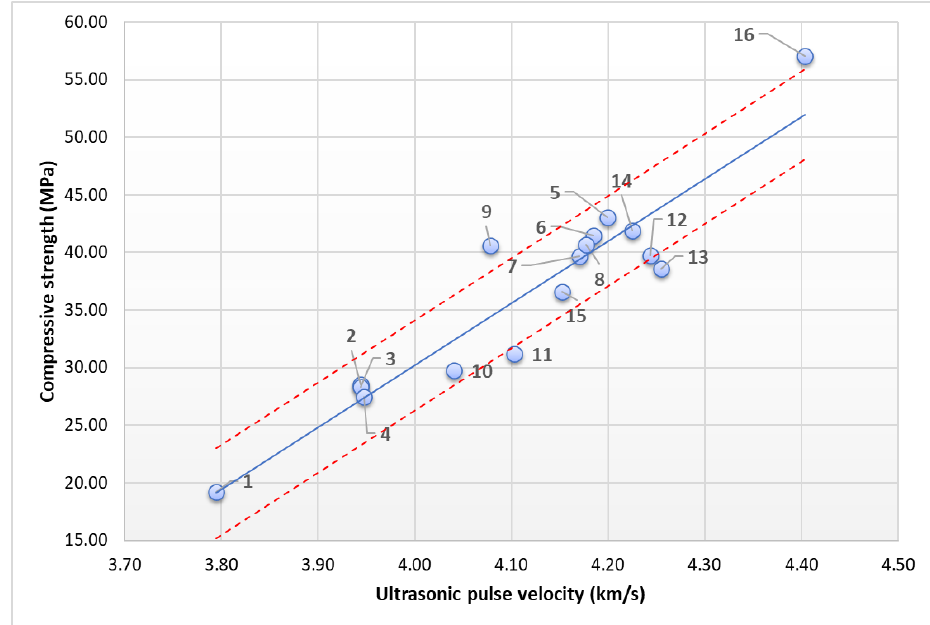
Figure 4. Presentation of the results of the compressive strength test concerning the calculated Ultrasonic Pulse Velocity of the natural mordenite. The blue dashed line represents the lineal trend of the values, and the red dashed lines represent the limits set with 95% confidence.